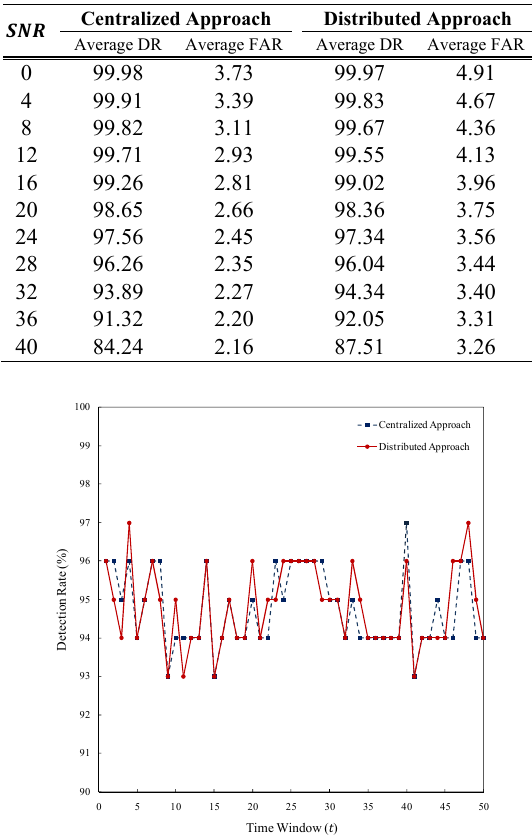
Figure 9. Detection rate of the centralized and distributed approaches during 50 time windows.